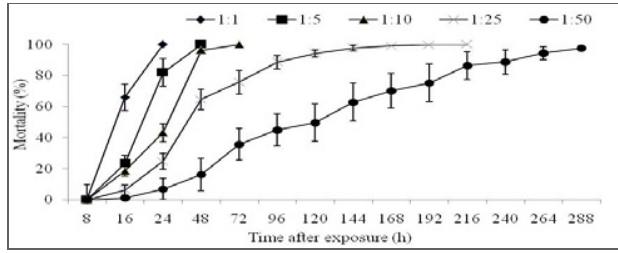
Fig 2. Average mortalities (± SE) of recipient C. formosanus at different donor-recipient ratios in the primary transfer of 1% fipronil dust of activated